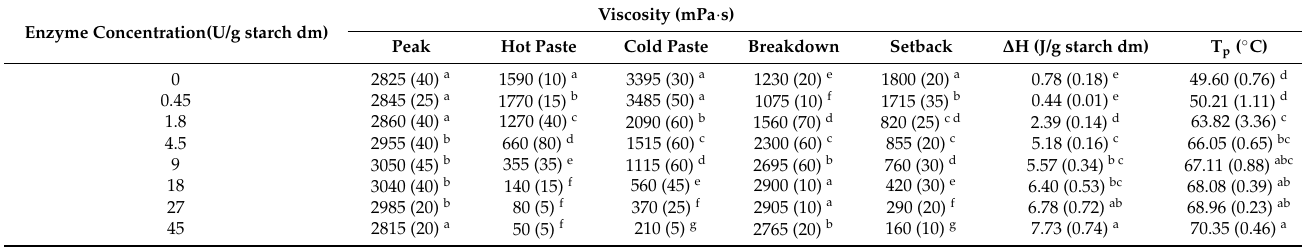
Table 1. Rapid visco analysis (RVA) properties of starch suspensions [10.0% w/w starch dry matter (dm)] treated with different dosages of amylomaltase (AMM, U/g starch dm) and melting enthalpies ( ∆ H) and peak melting temperatures (T p ) of the modified starches after storage at 5 ◦ C for 24 h.